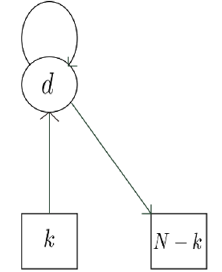
Figure 2 . The quiver diagram for N = 4 SQCD[ k; N ], and its vortex moduli space, a simple Handsaw quiver (see section